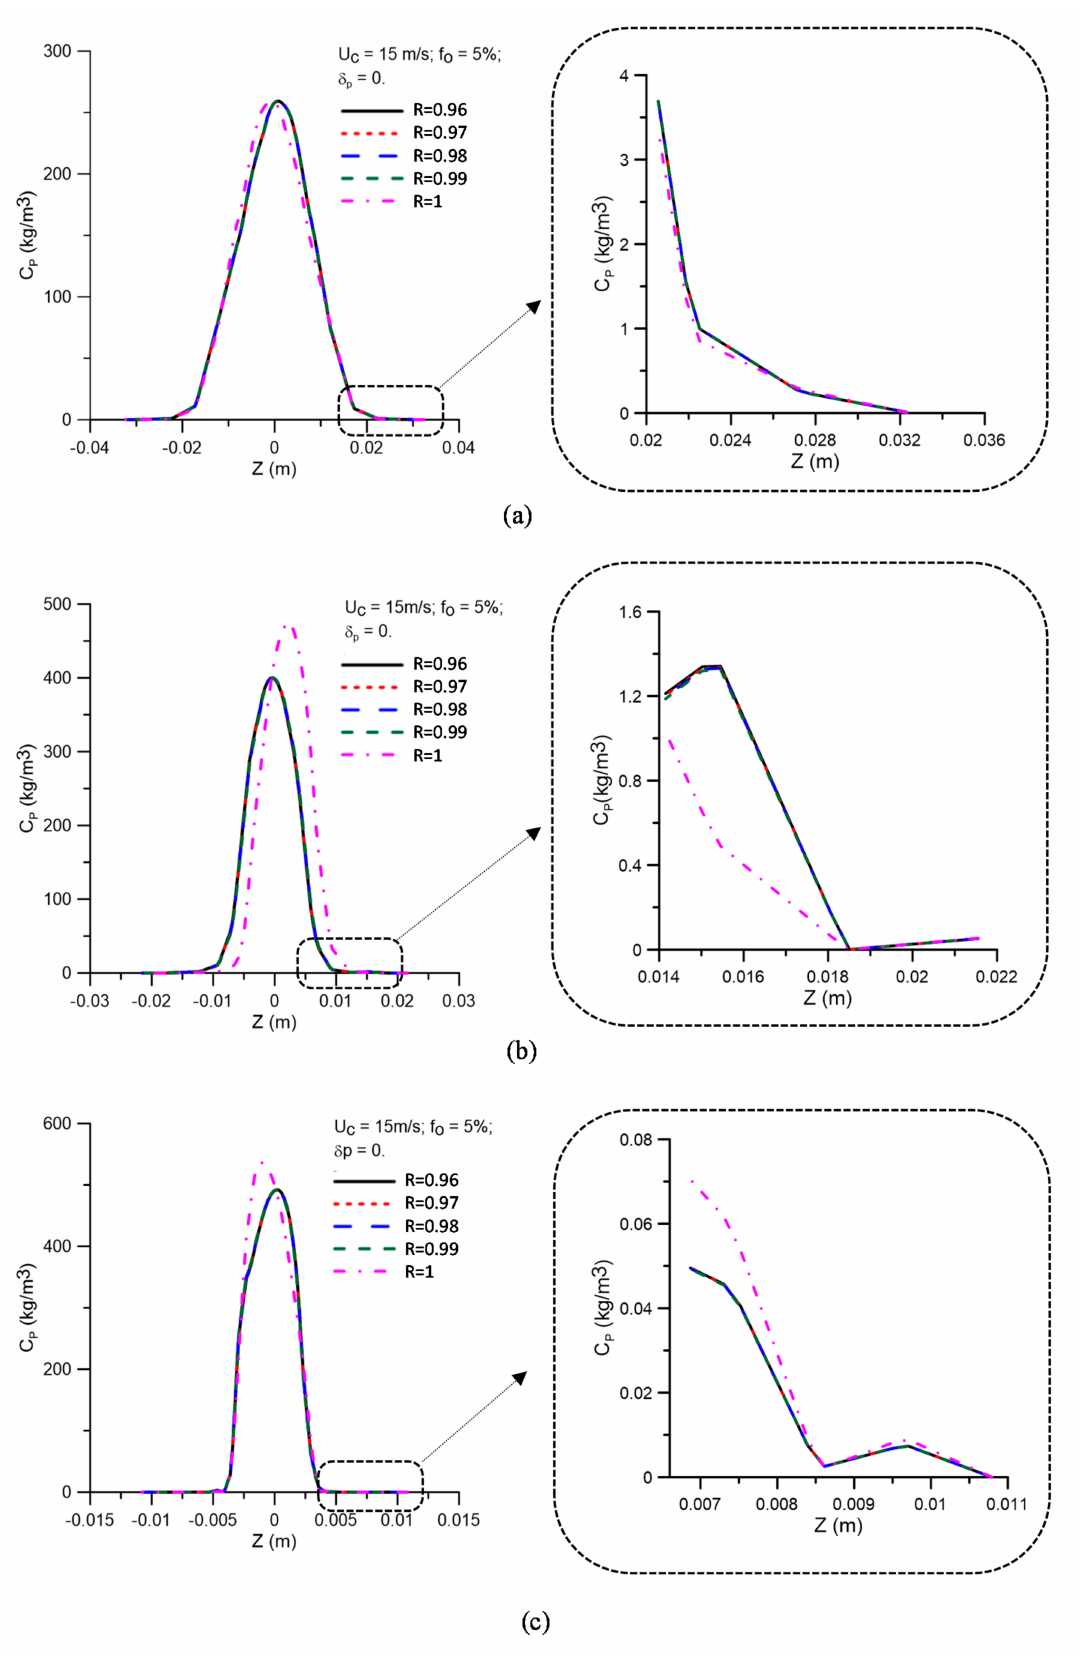
Figure 8. Oil concentration profiles for different values of the membrane rejection coefficient in the positions: ( a ) y = 0.15 m; ( b ) y = 0.45 m, and ( c ) y = 0.75 m, with δ p = 0